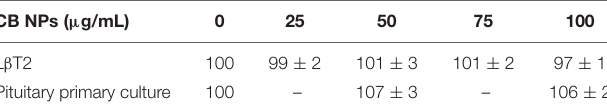
TABLE 2 | Effect of CB NPs on cellular viability of L β T2 cells or primary cultures of anterior pituitary